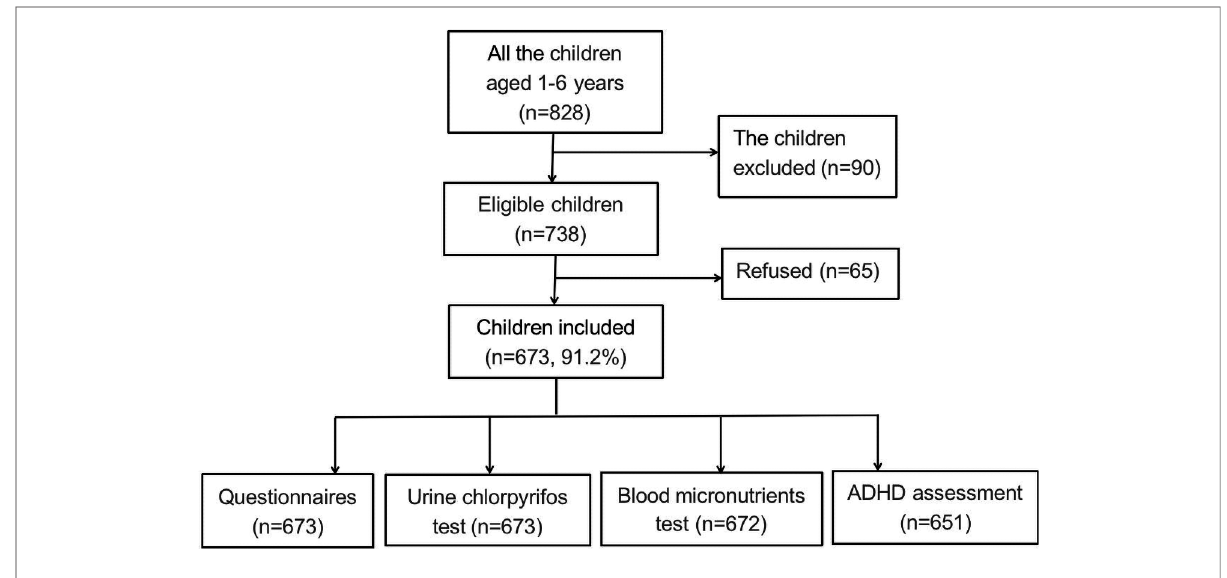
FIGURE 1 Research population and survey fl ow